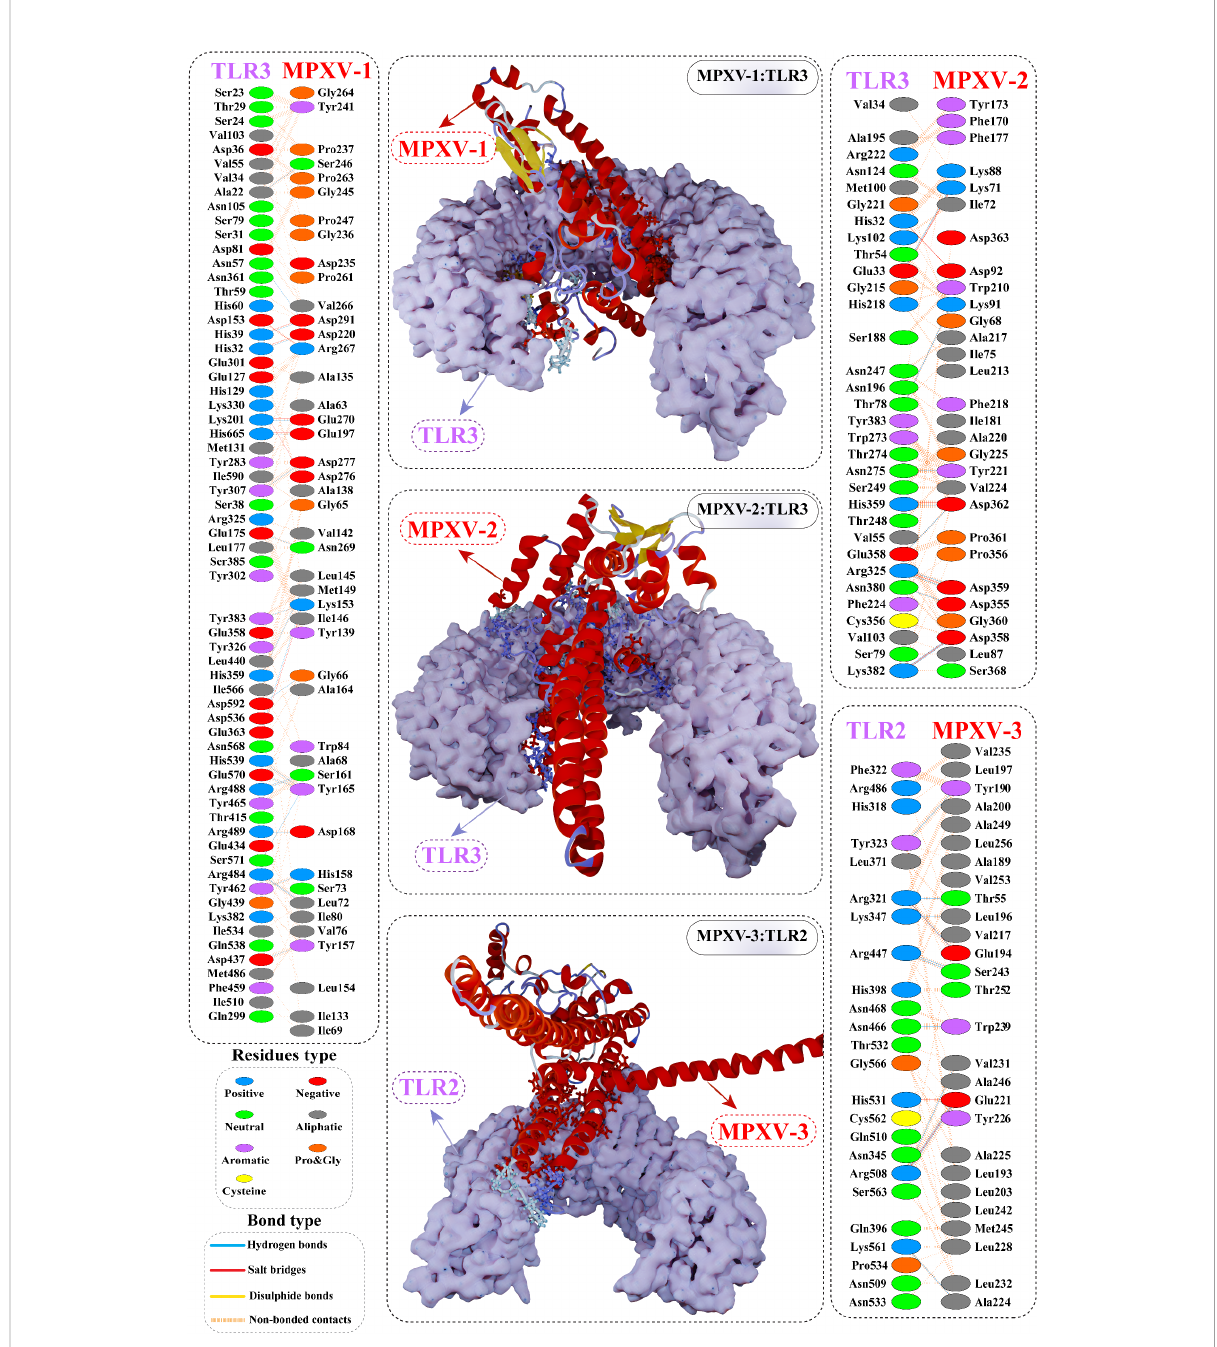
FIGURE 6 Optimal binding mode of MPXV vaccine construct with human Toll-like receptor-3 (TLR3) and TLR2 receptor. The docked complexes are illustrated in the middle. Protein-protein contacts of the vaccine construct with TLR3/2 receptor are shown on either side. Hydrogen bonds are depicted in blue lines. Residue type is shown with a distinctive